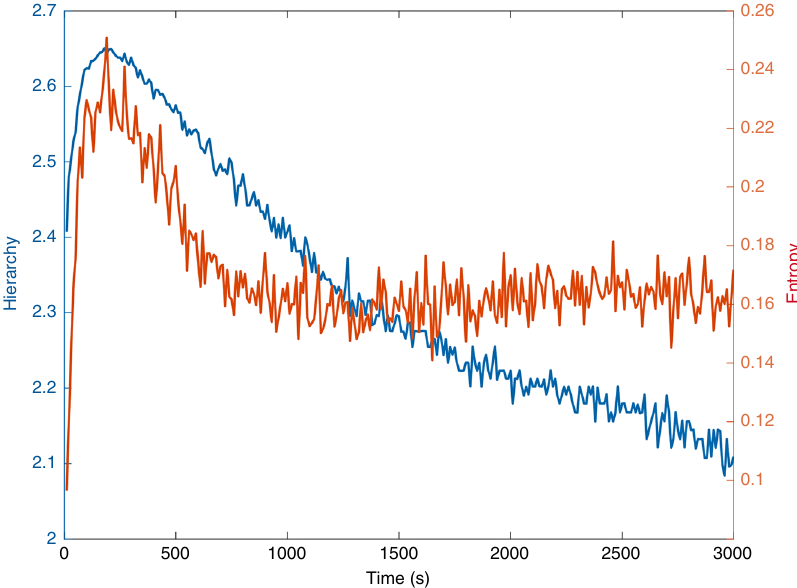
Fig. 6 Timescale in HCP task data. We analysed HCP task data (see Methods) in order to compare the optimal timescale for resting state and neuroimaging during a social cognition task, where participants were presented with short video clips (20 s) of objects (squares, circles, triangles) that either interacted in some way, or moved randomly on the screen. We fi tted the whole-brain model to the BOLD signal and plot the results of measuring entropy (red line) and hierarchy (blue line) in different bin sizes from 10 to 3000 ms. We found peaks in entropy and hierarchy of around 200 ms, which is very similar to the peak found in resting state fMRI. This means that the timescale for resting state and task condition is optimal at the same timepoint, suggesting that the 200 ms timescale is an intrinsic property of brain